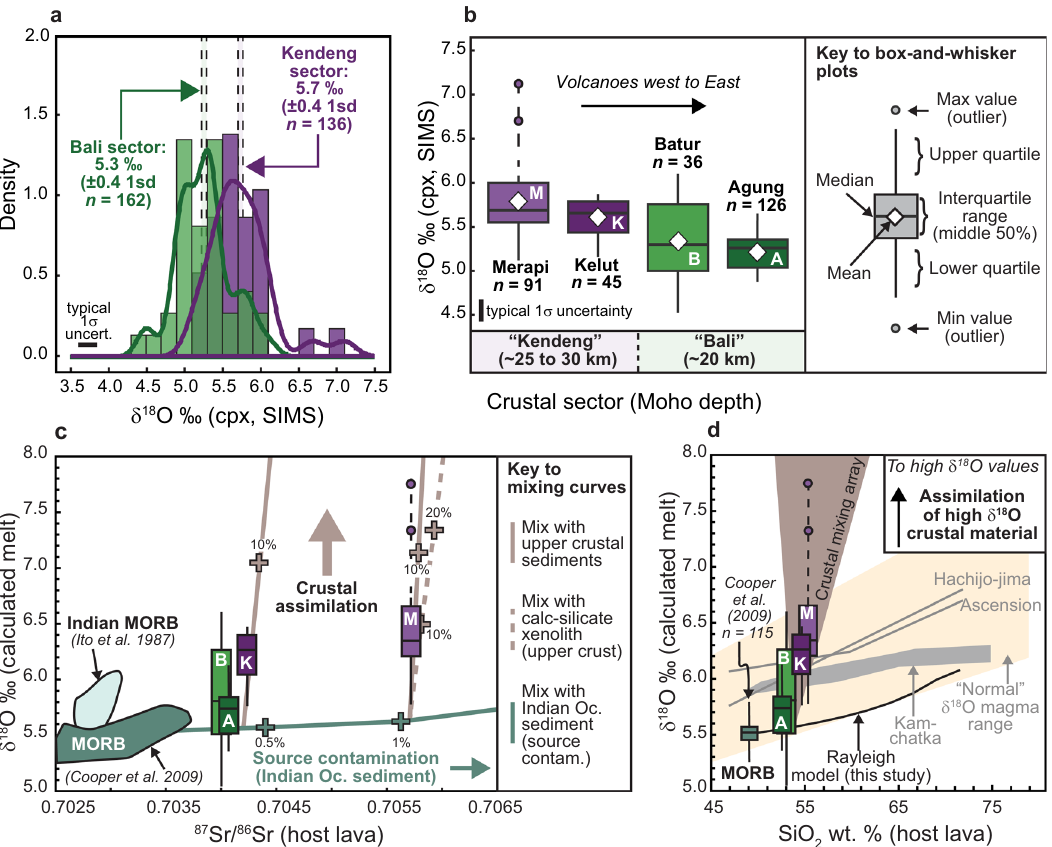
Fig. 3 Oxygen isotope results and models. a Histograms with density plot overlays showing grain averaged clinopyroxene SIMS δ 18 O values for investigated volcanoes from the Bali and Kendeng sectors. Histogram bins are at 0.2 ‰ . b Box-and-whisker plots showing grain averaged clinopyroxene SIMS δ 18 O values for each studied volcano. White diamond symbols denote the overall mean δ 18 O clinopyroxene value for each data group. c Box-and- whisker plots showing equilibrium melt δ 18 O values calculated from the SIMS data for Agung (A), Batur (B), Kelut (K), and Merapi (M) versus 87 Sr/ 86 Sr in host lavas. Source and crustal contamination models are shown utilising average MORB from refs. 48,49 , Indian Ocean sediment after ref. 29 , and Java crustal compositions in refs. 13,31,35 . d Equilibrium melt δ 18 O values versus SiO 2 contents of host lavas. Oxygen isotope fractionation trajectories are shown in grey for several natural systems after refs. 24,75 . A closed system Rayleigh fractionation model was additionally calculated based on ref. 18 starting from mean MORB 48 . Oxygen isotope magma – crust mixing trajectories are shown in brown, utilising Java crustal compositions in refs. 13,31,35 . Average propagated uncertainties are 0.25 ‰ (1 σ ) for the SIMS data and 0.000011 (2 σ ) for the Sr isotope data (smaller than symbol size). Abbreviations: cpx, clinopyroxene; Moho, Mohorovi č i ć discontinuity; Oc, ocean; uncert.,